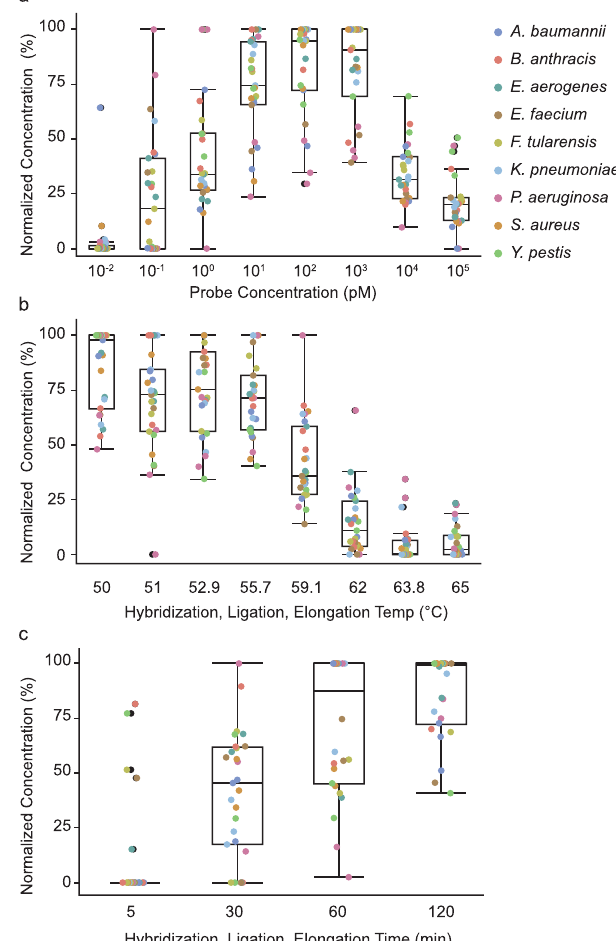
Figure 1. MIP protocol optimization for the 16S probeset. Pooled 16S MIPs were tested against DNA extracts of representative biothreats and ESKAPE pathogens to optimize target capture conditions including ( a ) probe concentration, ( b ) reaction temperature and ( c ) reaction duration. Amplicon formation was quantitatively measured after probe circularization and amplification with the universal primer set across three replicates for each organism at each variable. Concentrations were normalized to 0% and 100% representing the lowest and highest concentrations across the experimental range. Data points for each organism were combined and a corresponding outlier box plot was generated for each